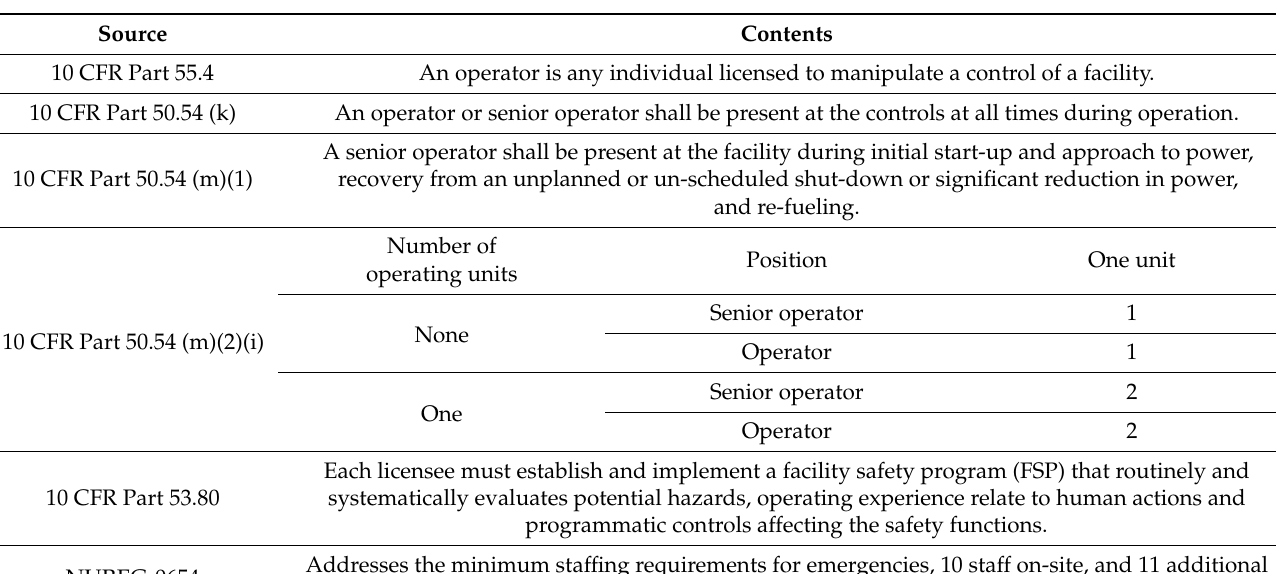
Table 5. Regulations and regulatory guides related to operations